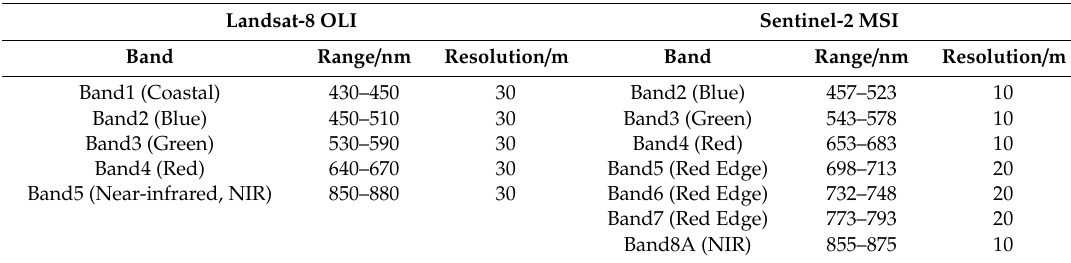
Table 1. Overview of spectral bands of Landsat-8 OLI (Operational Land Imager) and Sentinel-2 MSI (Multispectral Instrument) data from 400 to 900 nm.